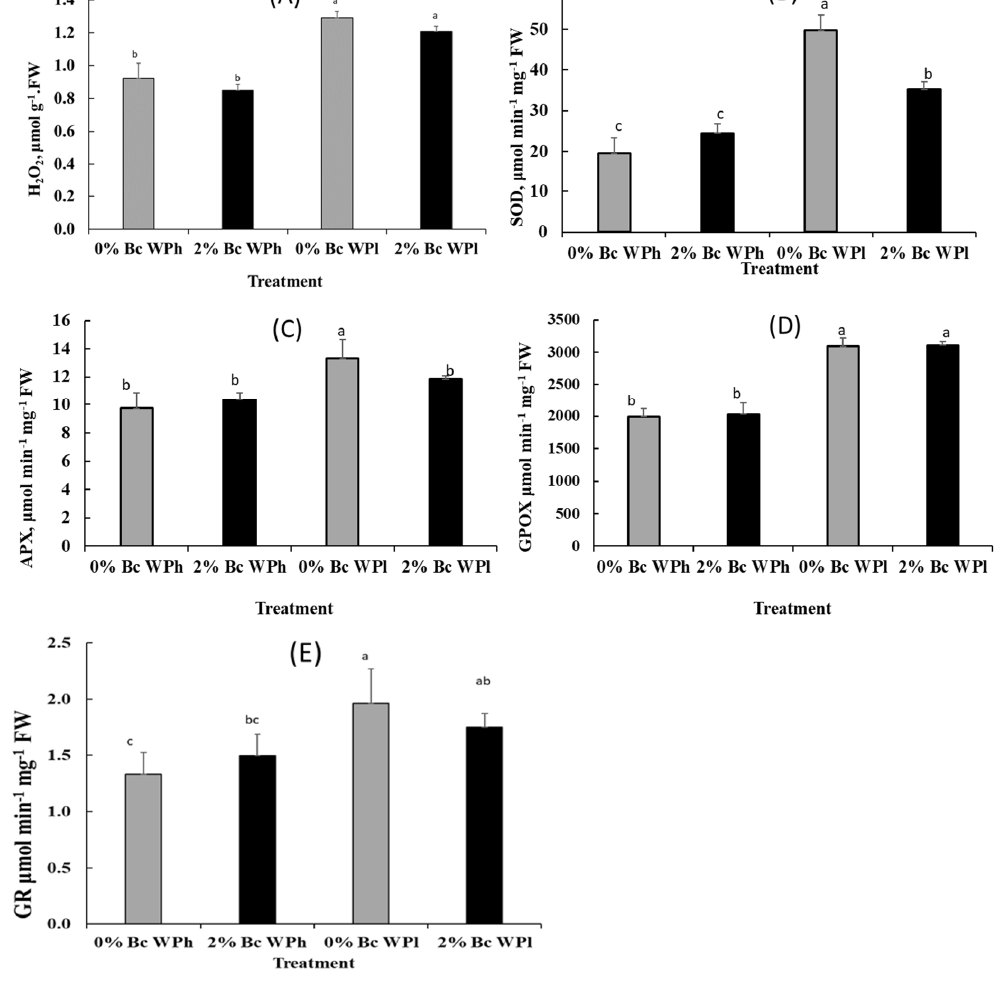
Figure 7. Varietal differences in the content of H 2 O 2 ( A ) and the enzymatic activities of SOD ( B ), APX ( C ), GPOX ( D ), and GR ( E ) in Medicago ciliaris leaves after 3 weeks of drought treatment. Values represent mean ± SE ( n = 5) and the different letters a to c indicate significant differences between the treatments. Low soil water potential (WPl), high soil water potential (WPh), Biochar (Bc).